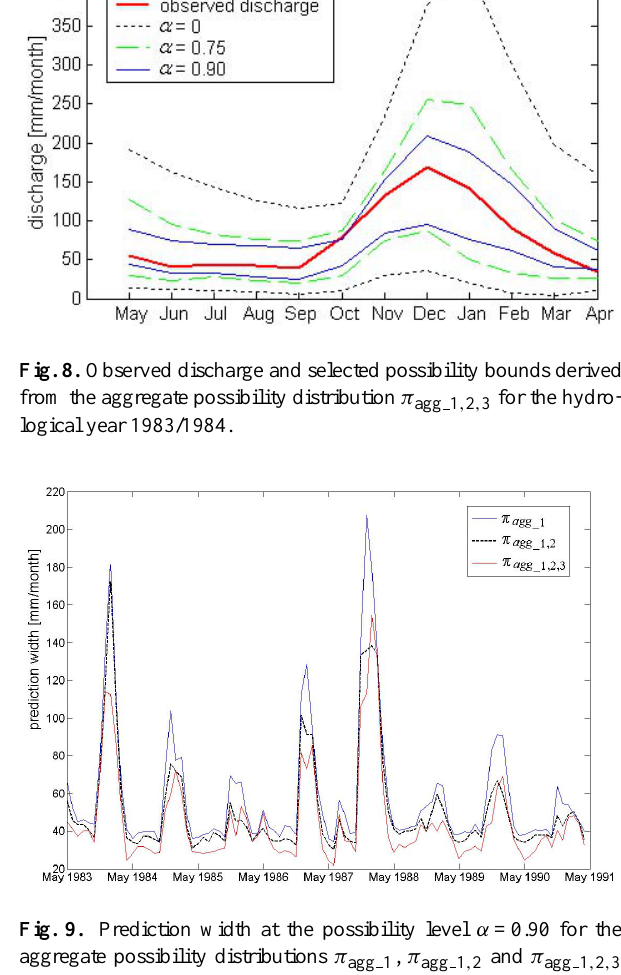
Table 1. Fraction of observations not enclosed by the possibility bounds at selected possibility levels α during the verification period.